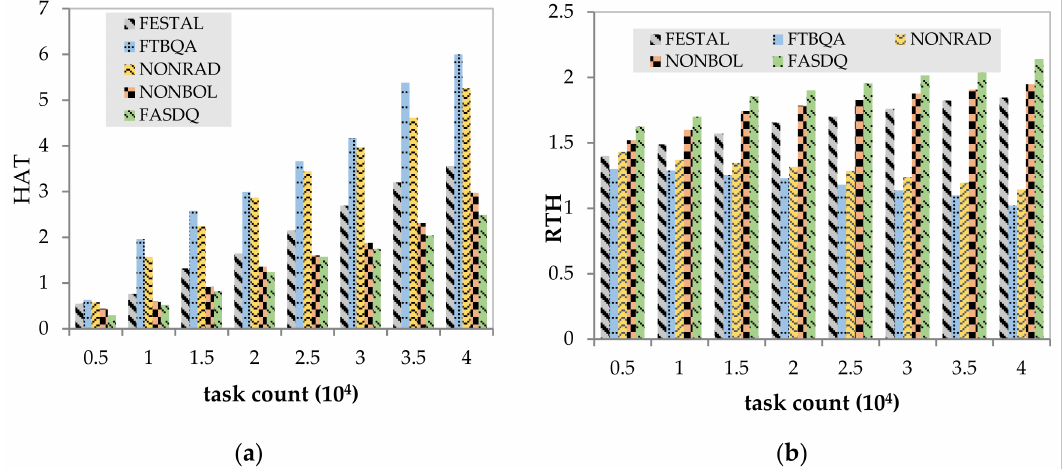
Figure 11. Comparison of resource utilization. ( a ) Impact of task count on HAT (the total active time of the edge nodes); ( b ) impact of task count on RTH (the ratio of the task service time to the active time of the edge